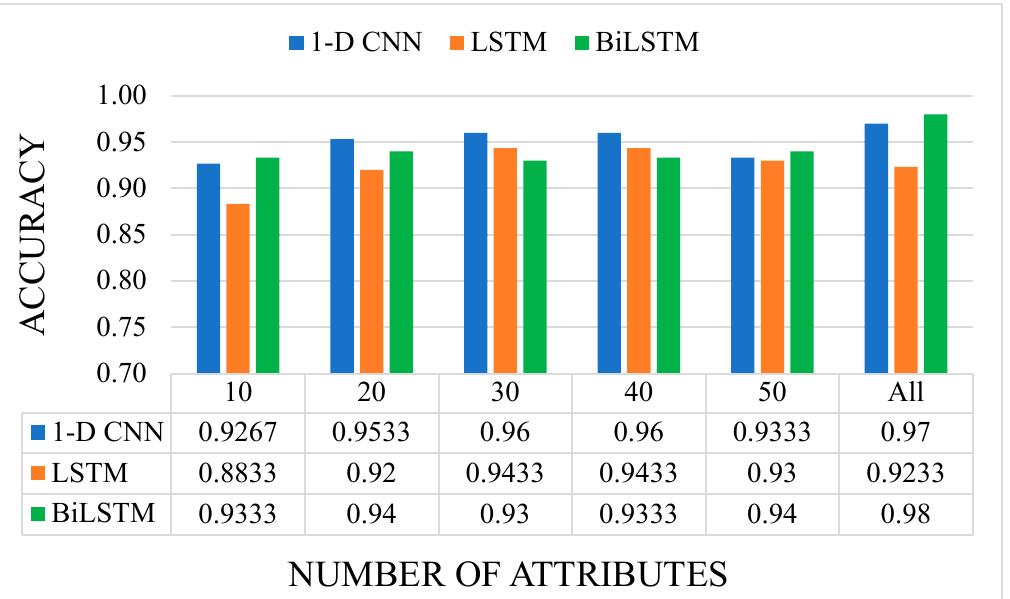
Figure 10. The accuracy results of the DL models on cancer stage classification with different numbers of attributes. (Illustrations by the authors).